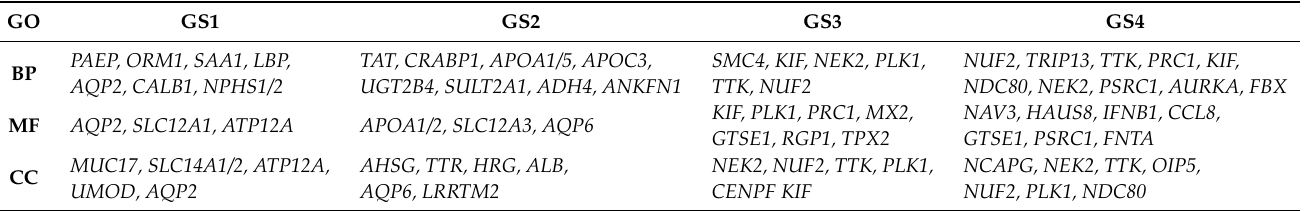
Table 7. Genes most involved in the top three terms of each ontology (BP, MF and CC) for each gene set studied. GS1—logFC tumor vs. normal; GS2—logFC early vs. advanced stage; GS3—EN β coefficients; GS4— TCox β